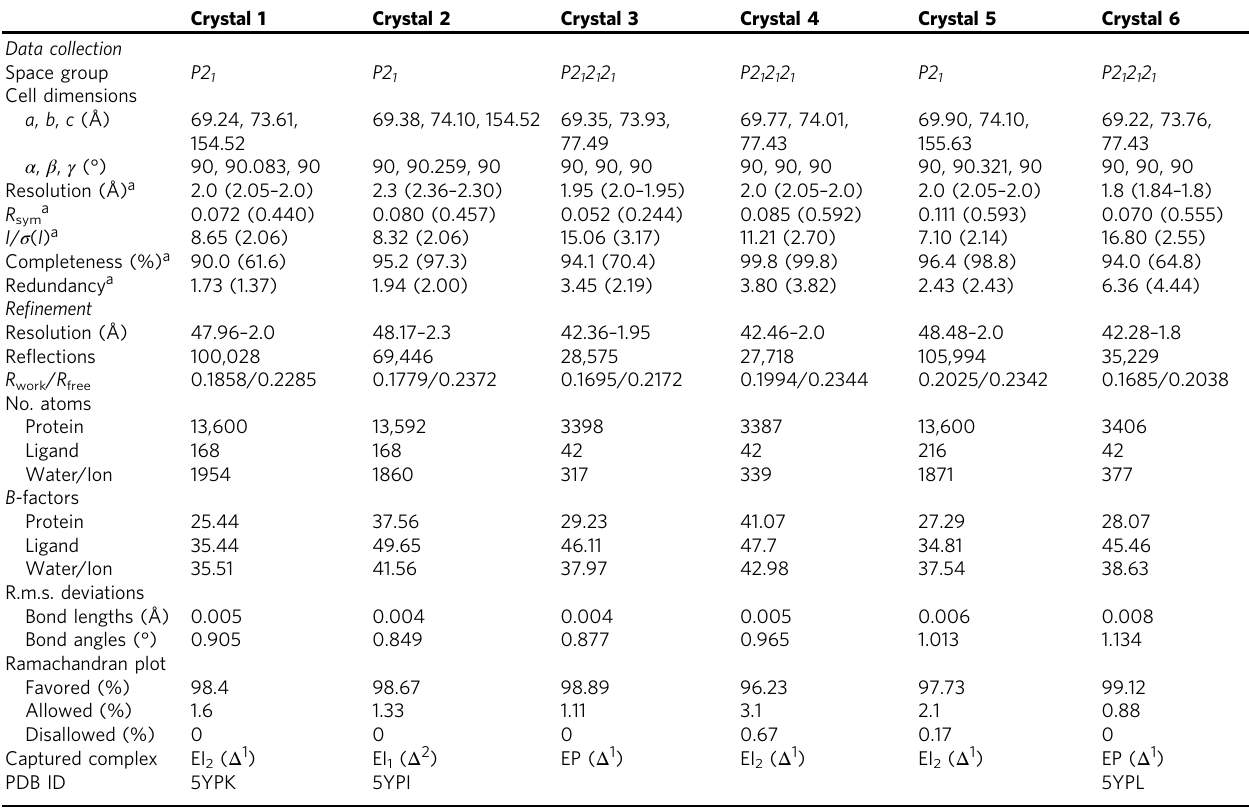
a Values in parentheses are for highest-resolution